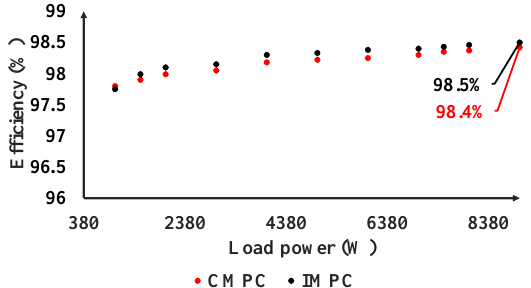
Figure 9. Measured efficiency of the three-phase voltage source converter (VSC) using the variable switching frequency schemes, feeding a linear load.